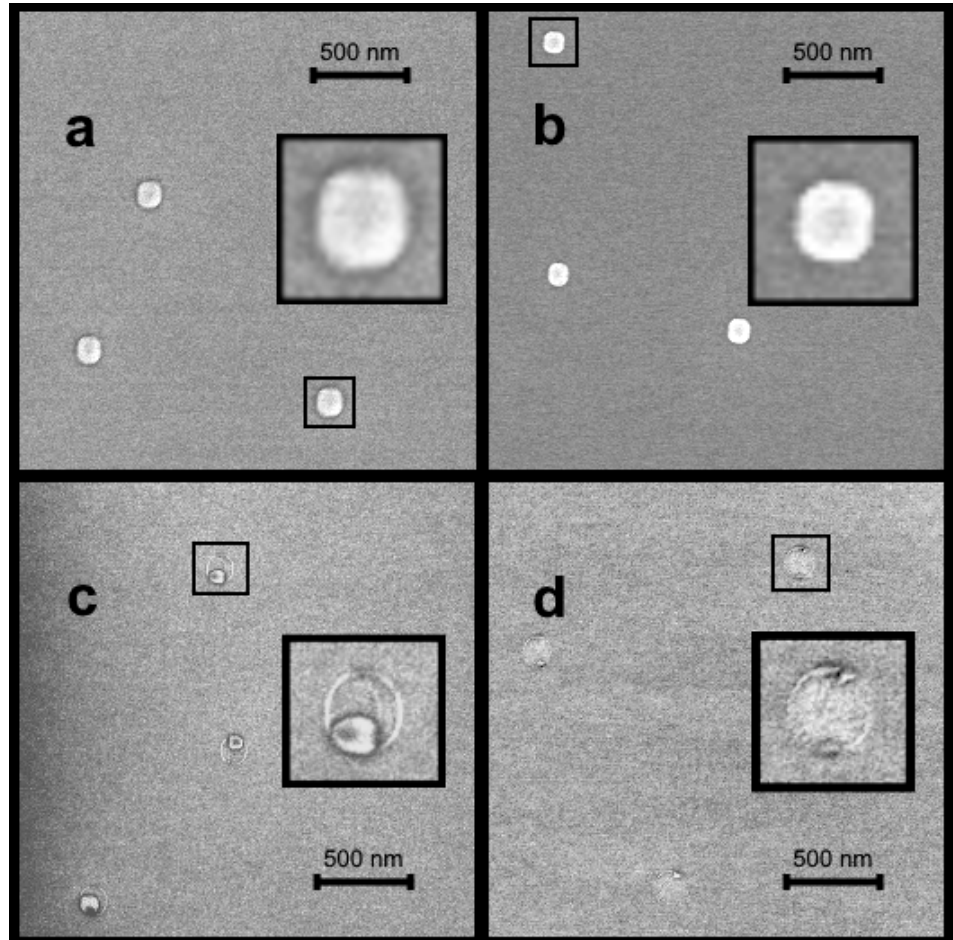
Figure 1. SEM images of nanostructures obtained after deposition of 3 ML of indium and further exposure to the ultra-low arsenic flux: ( a ) P/P 0 = 1; ( b ) P/P 0 = 4; ( c ) P/P 0 = 6; ( d ) P/P 0 = 8.1. The 250 × 250 nm 2 insets demonstrate scaled-up nanostructures.